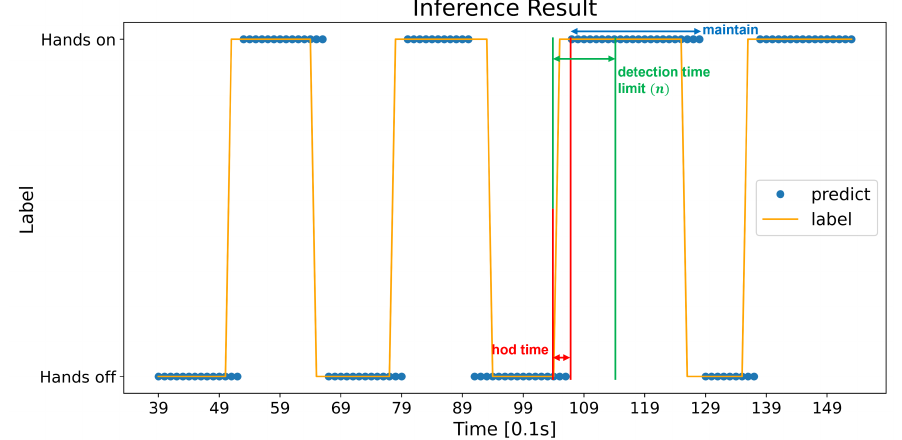
Figure 8. An example of calculating the HOD metric. The ground truth changes at 10.4 s and our model detected it at 10.7 s. The time difference between them is HOD time. If it is shorter than the detection time limit and maintains for at least a second, it is regarded as a correct